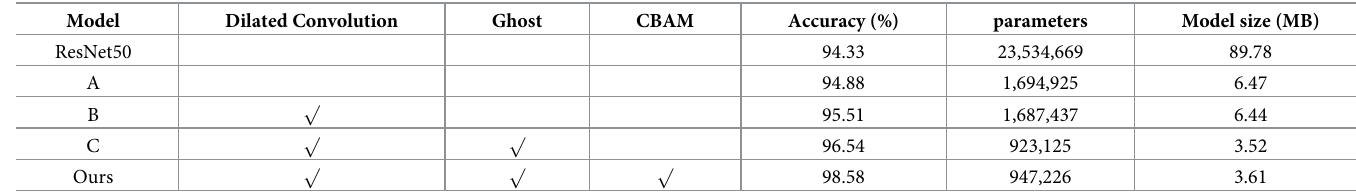
Table 2. Add module comparison results.